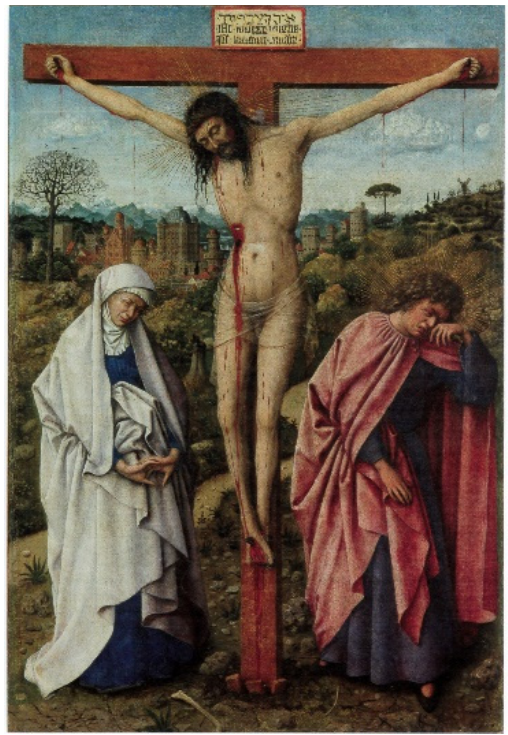
Figure 10. Jan van Eyck, workshop, Crucifixion , ca. 1430–1450, Berlin, Staatliche Museen zu Berlin.